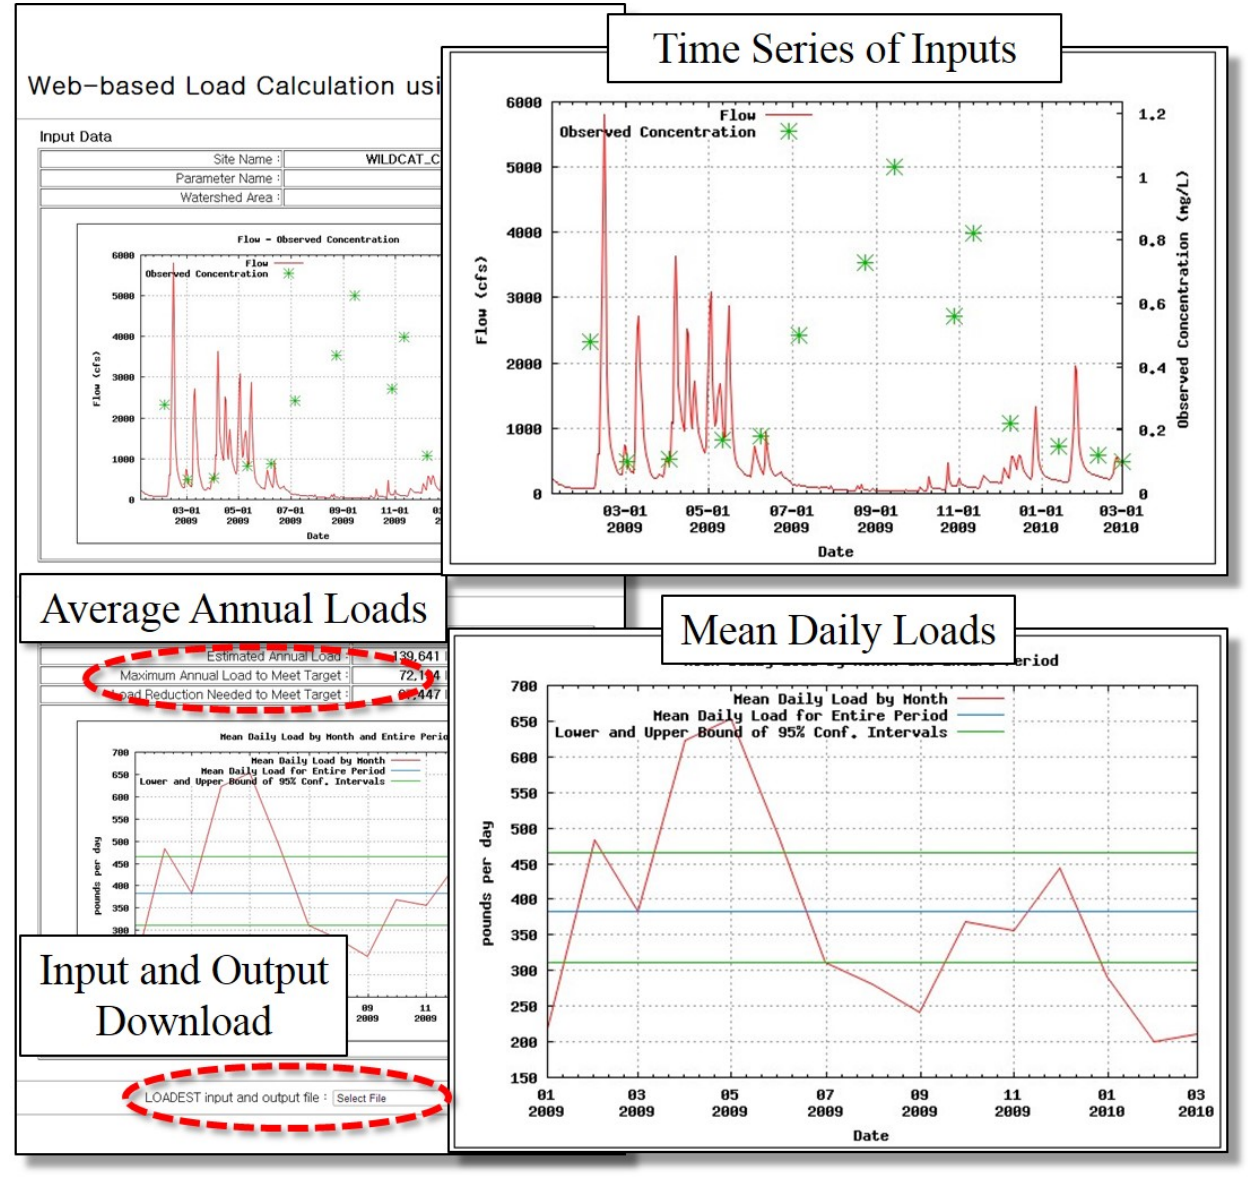
Figure 3. Output interfaces of LOADEST